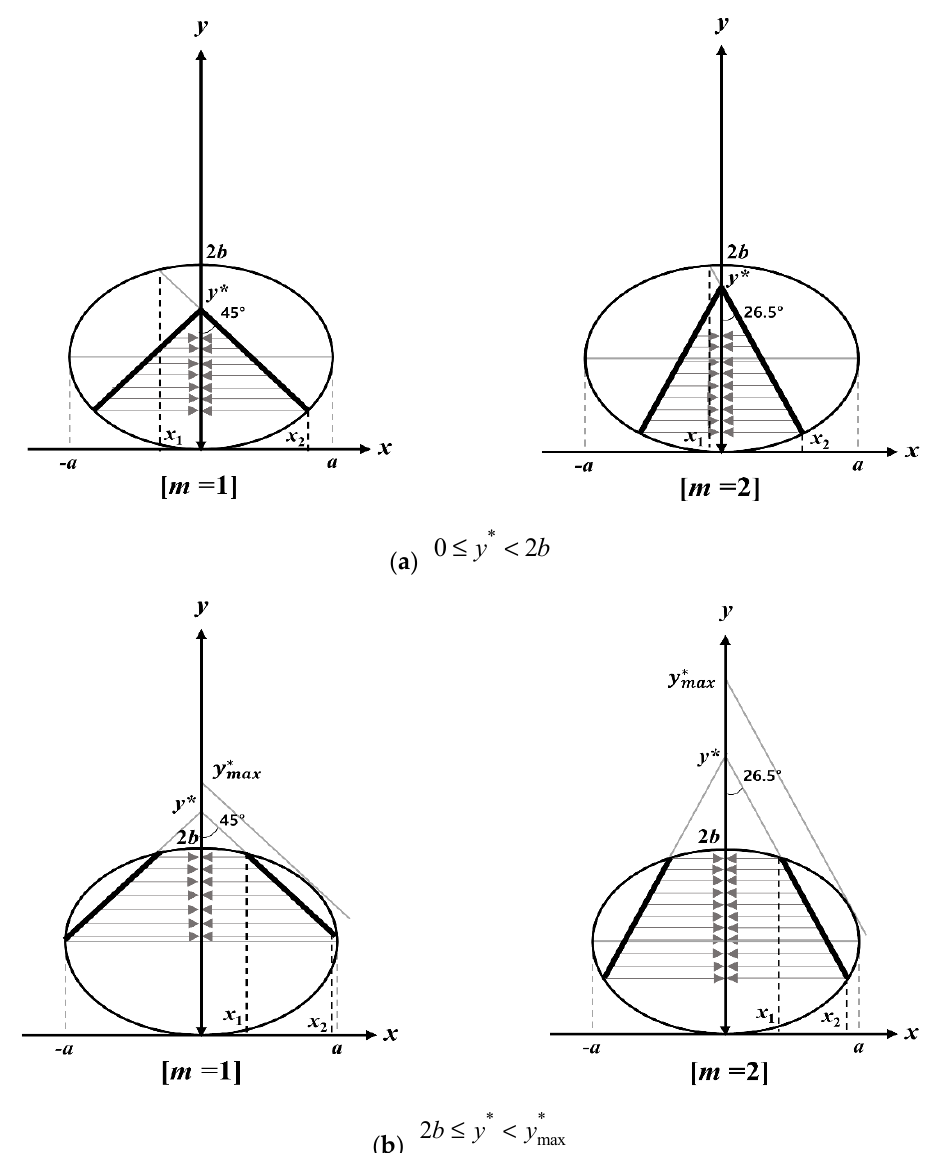
Figure 1. Comparison of contributing line segments (thick solid line) having the same travel time for m = 1 and m = 2 (where y * represents the channel length to make its travel time equivalent to both flows in the channel and hillslope).